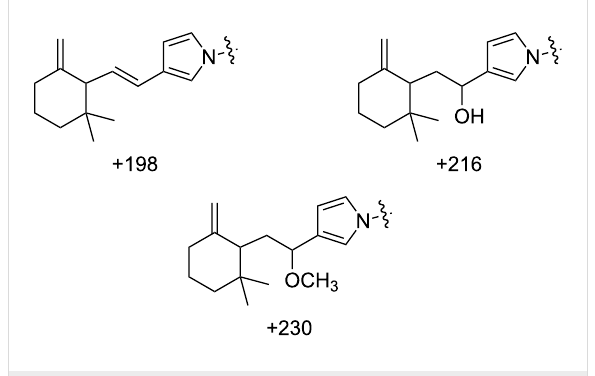
Figure 5: Lysine adducts arising from the reaction of onchidal ( 6 ) with lysozyme.